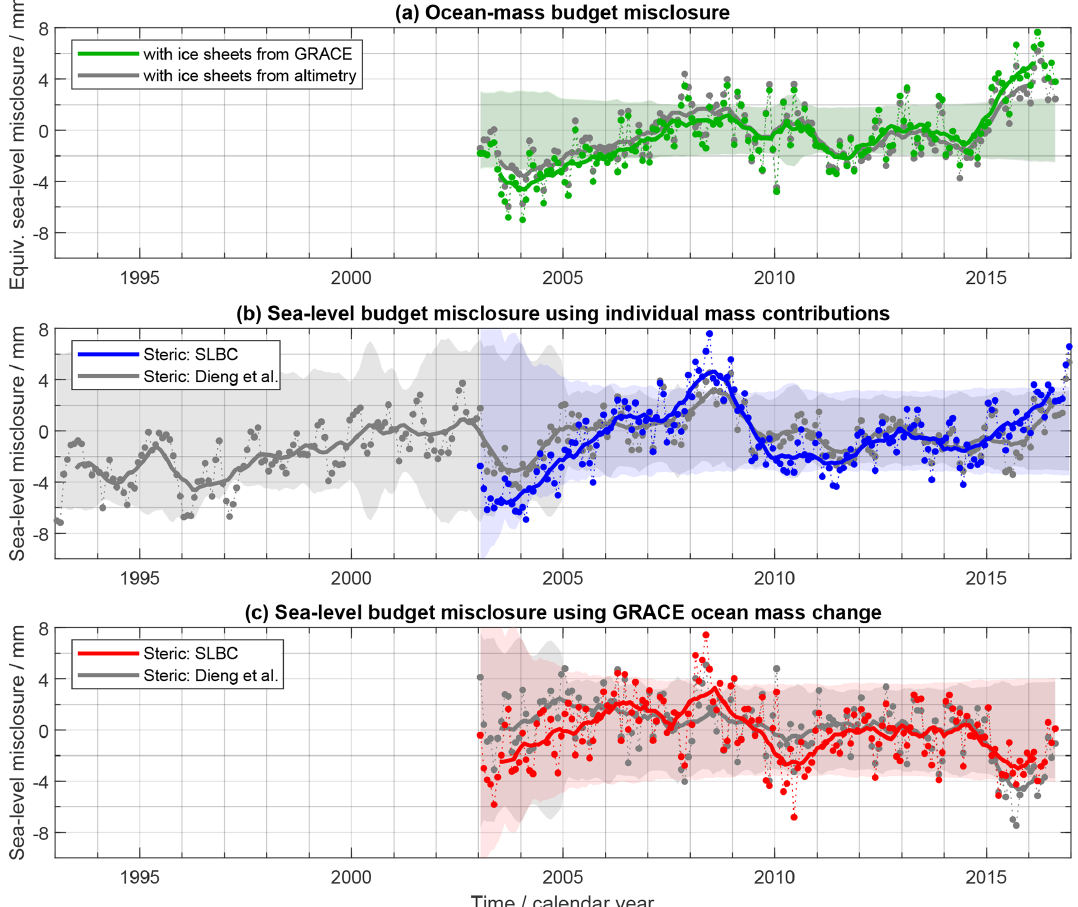
Figure 11. (a) Ocean-mass budget misclosure (GRACE-based OMC minus the sum of assessed contributions) for the time series of monthly anomalies of mass budget elements as shown in Fig. 10. Dots: monthly misclosure for the case of GRACE-based (green) and altimetry-based (grey) ice sheet assessments. Thick lines: running 12-month mean, for better visibility of interannual features. Shaded bands (green and grey, almost identical in the figure): combined standard uncertainty (1 σ ) of the monthly misclosure. (b) Sea-level budget misclosure (GMSL minus the sum of contributions) for the time series shown in Fig. 12 using the individual mass contributions (involving the altimetry-based ice sheet assessments). Dots, lines, and shaded areas have the same meanings as in panel (a) . Blue and grey: results employing the SLBC_cci steric data product and the Dieng et al. (2017) ensemble mean dataset, respectively. (c) Same as panel (b) but with application of GRACE-based OMC, instead of the sum of assessed mass contributions. Red and grey: results employing the SLBC_cci steric data product and the Dieng et al. (2017) data product,